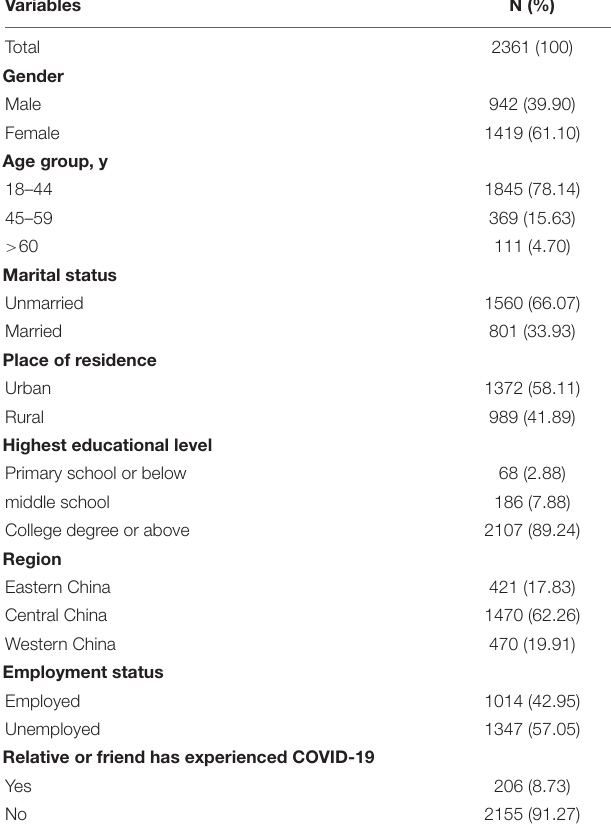
TABLE 1 | Statistical description of study